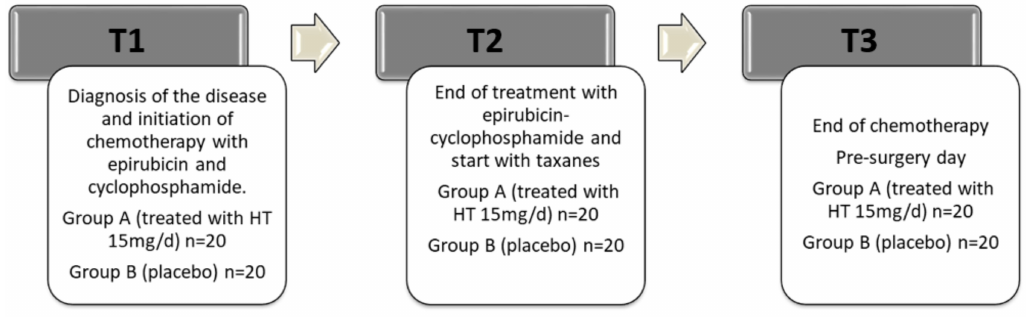
Figure 1. Timeline of the clinical study. T1 : study start, total time of the period 63 days, three cycles of chemotherapy with epirubicin and cyclophosphamide, 21 days each cycle. T2 : star of treatment with taxanes, total time of the period 63 days, three cycles of chemotherapy, 21 days each cycle. T3 : end of chemotherapy treatment and pre-surgery day. HT dose 15 mg / d from T1 until